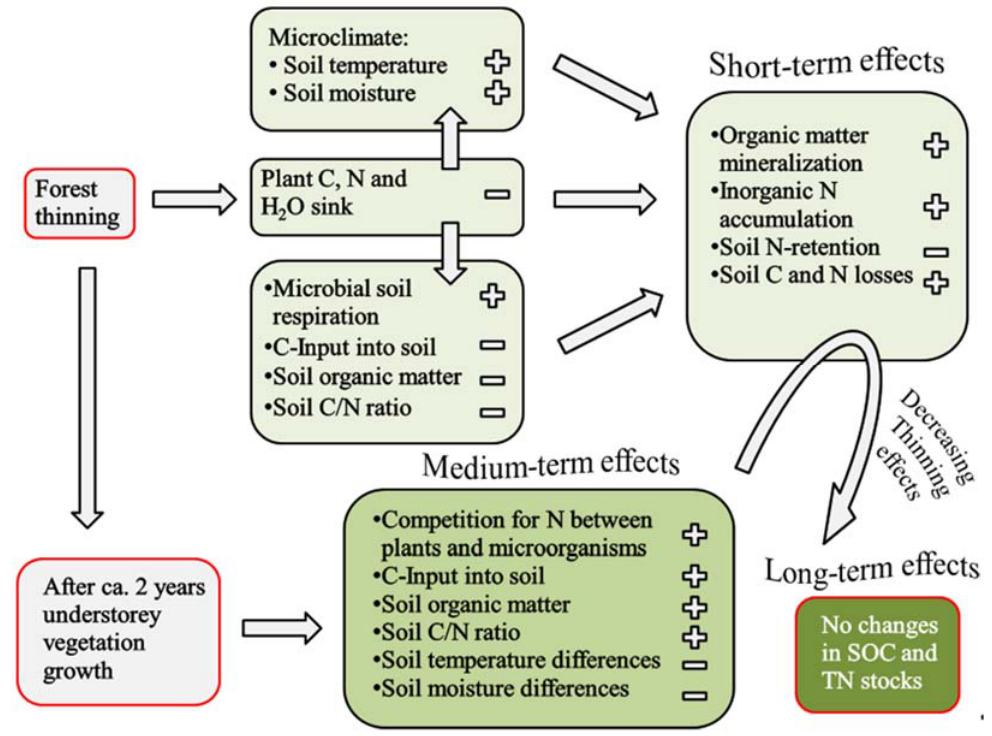
Figure 4. Conceptual model of thinning effects on soil C and N turnover.